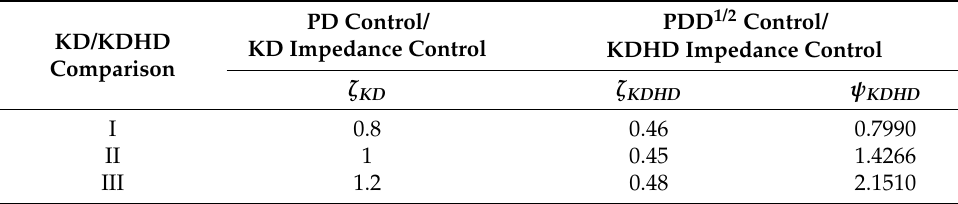
Table 2. Nondimensional parameters of the compared PD and PDD 1/2